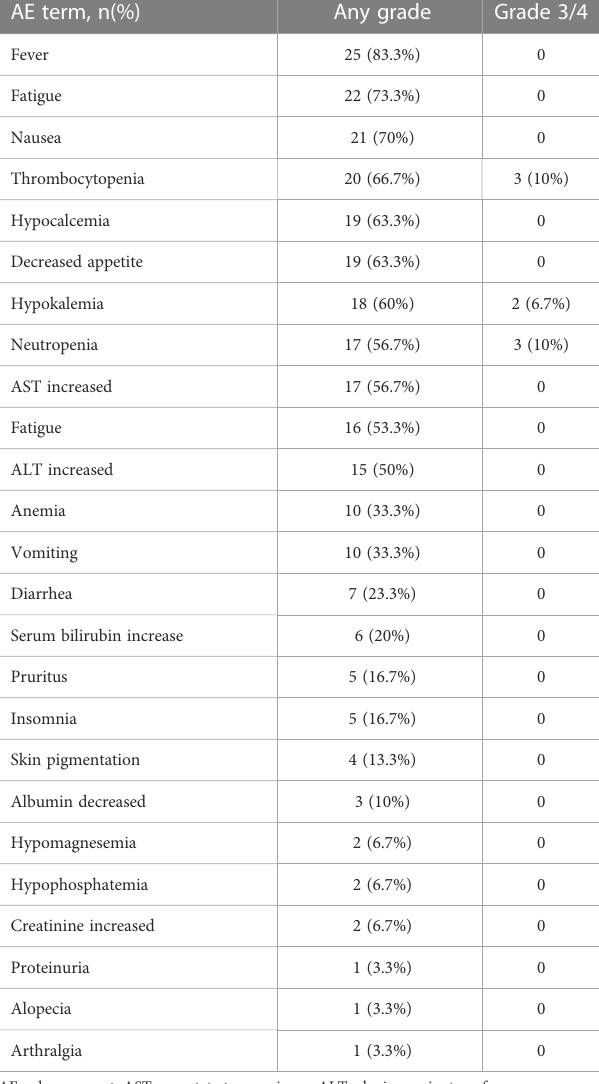
TABLE 5 Summary of the treatment-related adverse events.